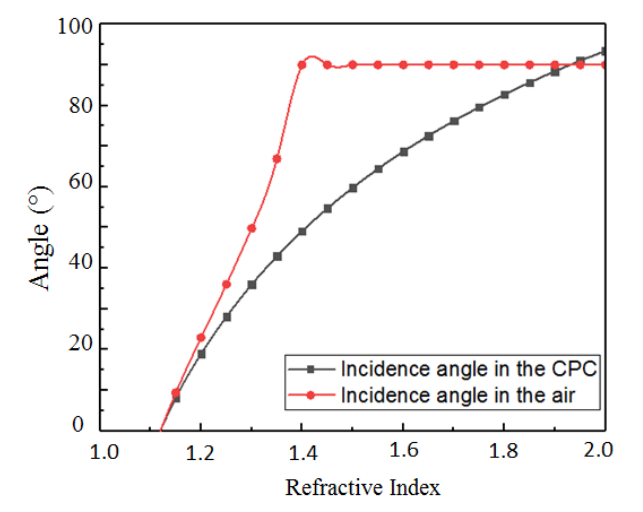
Figure 21. Maximum input and output acceptance angles for a filled CPC.